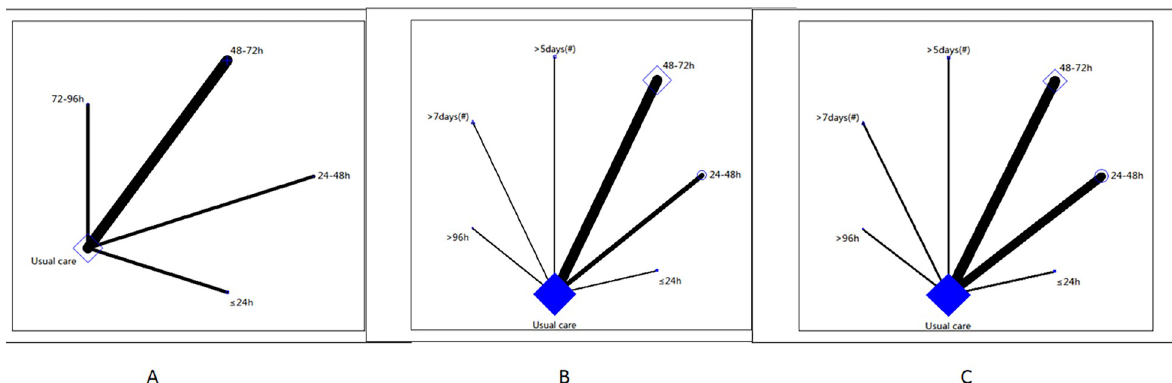
Fig 3. Network plot of included studies. A: Network plot of ICU acquired weakness. B: Network plot of duration of mechanical ventilation. C: Network plot of ICU length of stay.